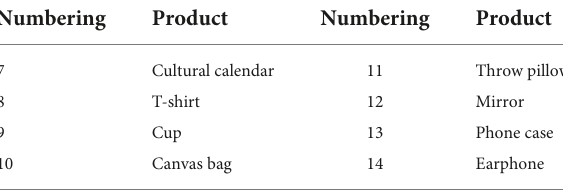
TABLE 3 Product 2 of Hakka culture brand image design.